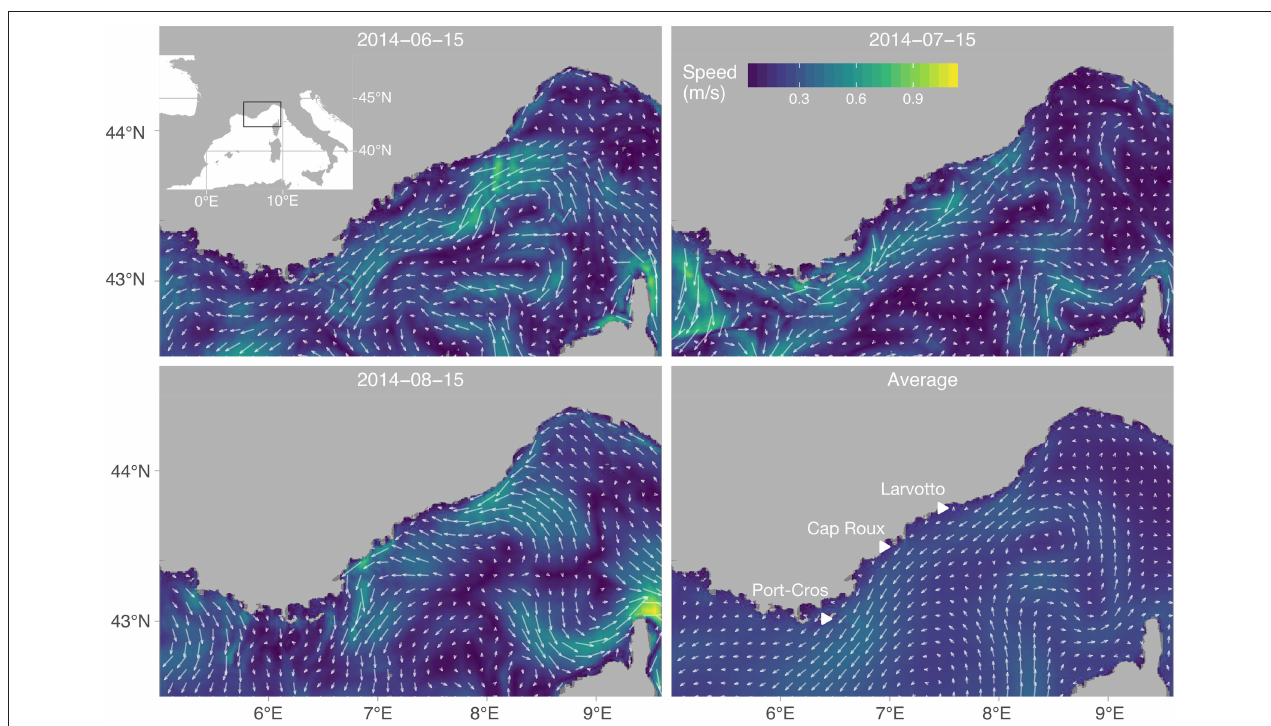
FIGURE 1 | Map of the study region, with simulated current field snapshots at 5m depth and averaged over the study period. Flow vectors are overlaid on top of a linearly interpolated map of average current intensity. The typical strong jet along the northern coast is highlighted, as well as two stable mesoscale eddies: a well defined cyclone (counterclockwise) centered on 8.5 ◦ W, 43.5 ◦ N and a weaker anticyclone below. Triangles indicate the three MPAs from where virtual larvae were